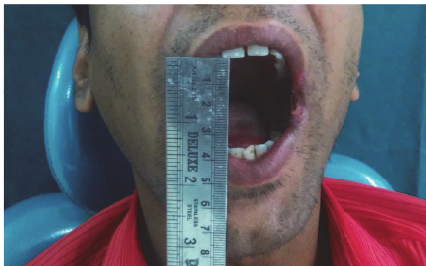
Figure 9: 35th postoperative day passive mouth opening—35 mm.